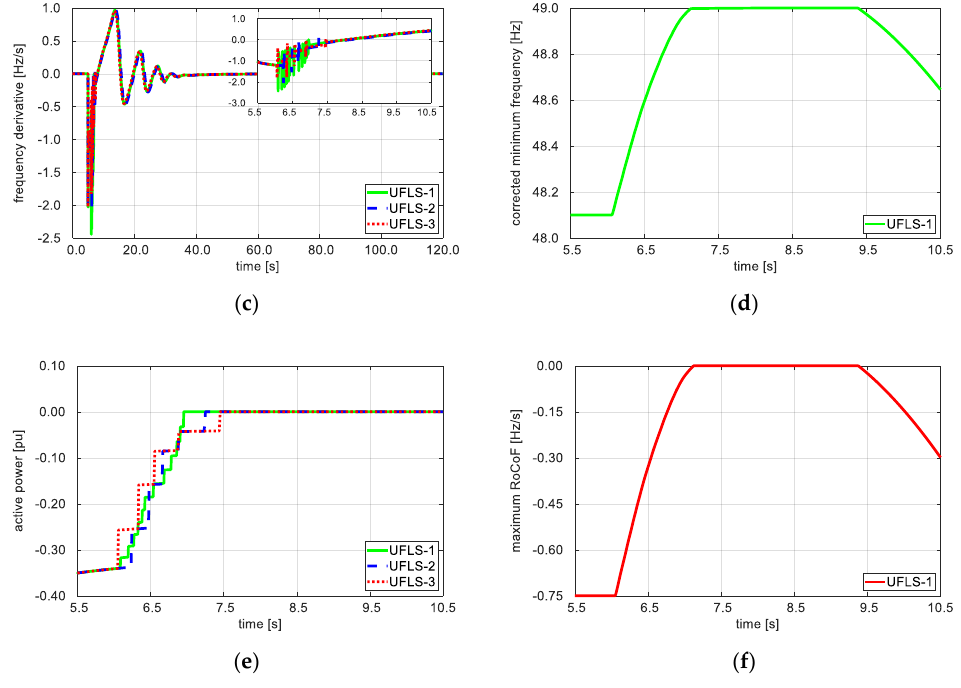
Figure 7. Time variation of selected variables during the unloading process—Case C: ( a ) frequency, ( b ) membership functions and UFLS output y , ( c ) frequency derivative (RoCoF), ( d ) corrected minimum frequency f * min , ( e ) active power disconnected, ( f ) maximum RoCoF f (cid:48)∗ max .